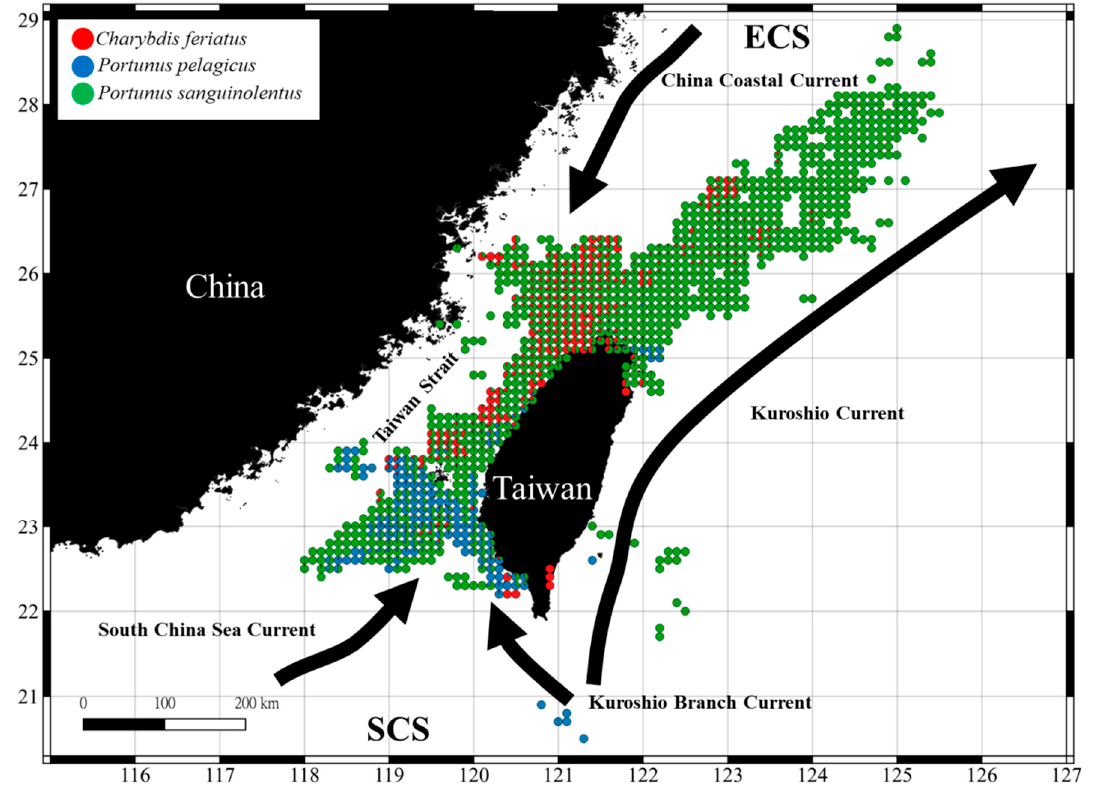
Figure 1. Spatial distributions of catch of C. feriatus , P. pelagicus , and P. sanguinolentus caught using crab traps from 2011 to 2016 in the Taiwan Strait (TS). Remote Sens. 2020 , 12 , x FOR PEER REVIEW